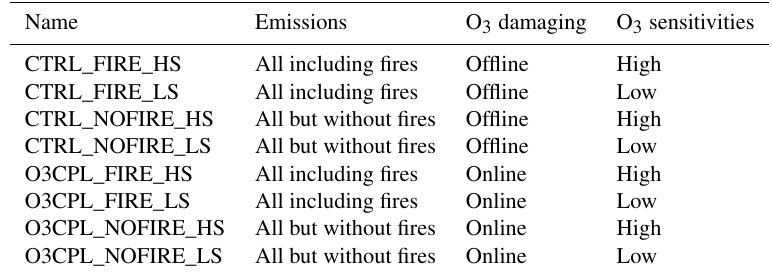
Table 1. Summary of simulations using the GC-YIBs model.